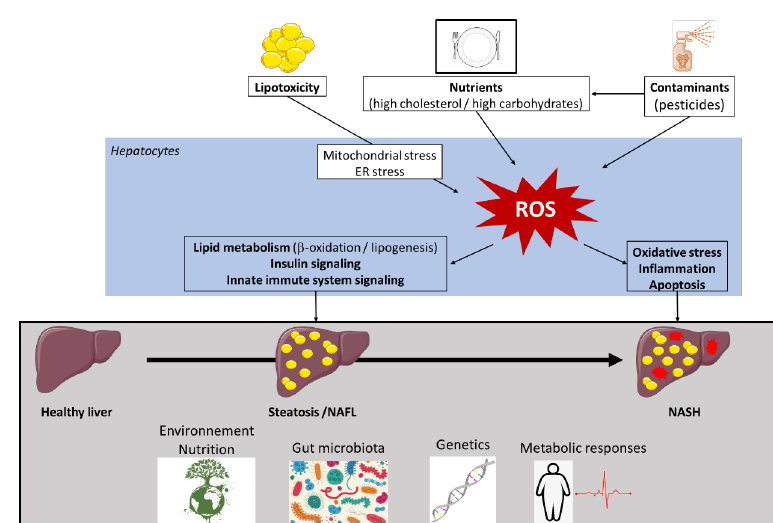
Figure 1. Factors involved in non-alcoholic fatty liver disease (NAFLD) pathogenesis. Multiple causes, including metabolic factors, gut microbiota, and environmental factors, operate in the context of the specific genetic background of individuals for the development of non-alcoholic fatty liver disease (NAFLD). Lipid overload induces lipotoxicity that a ff ects di ff erent reactive oxygen species (ROS) generators, such as mitochondria, peroxisomes, and endoplasmic reticulum (ER). As environmental factors, solid and liquid foods and their contaminants contribute to ROS production. ROS generation triggers changes in insulin sensitivity, the activity of key enzymes of lipid metabolism, innate immune system signaling, inflammatory responses, and liver apoptosis. High levels of ROS enhance oxidative stress, thuscreatingaviciouscircle. Collectively, theseconditionscontributetoNAFLDdevelopmentand progression. Other abbreviations: NAFL, non-alcoholic fatty liver; NASH, non-alcoholic